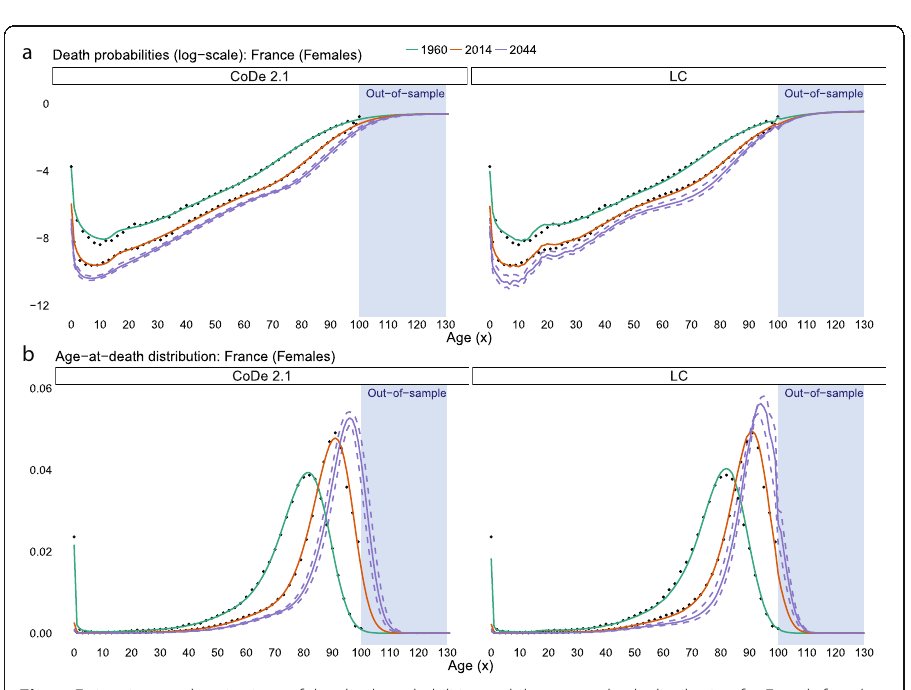
Fig. 5 Estimations and projections of the death probabilities and the age-at-death distribution for French females for the years 1960, 2014, and 2044 and for ages 0 – 130. CoDe 2.1 (left) and LC (right). The dotted lines are observations and the dashed lines are 95% projection intervals. The reference period is 1960 – 2014 for ages 0 –